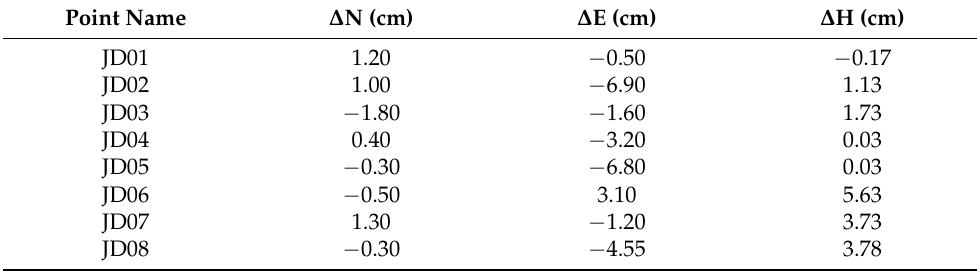
Table 2. Point cloud